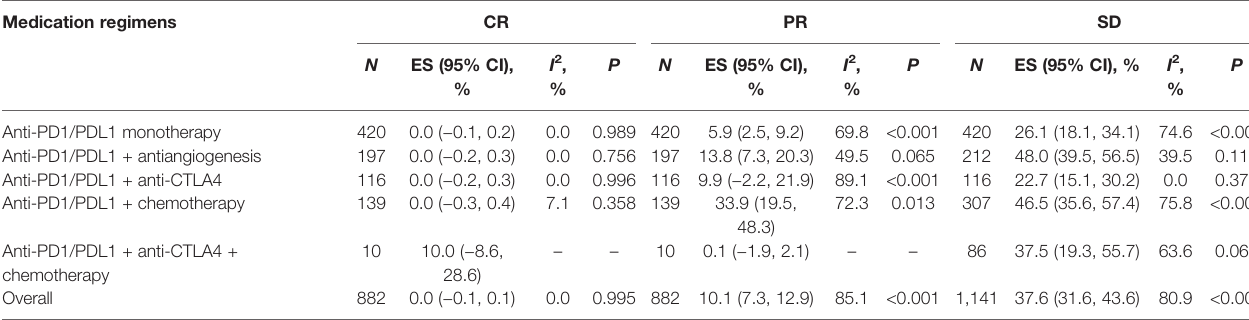
TABLE 3 | Pooled results of CR, PR, SD in total and by medication regimens subgroup with anti-PD1/PDL1 in aBTC. Medication regimens